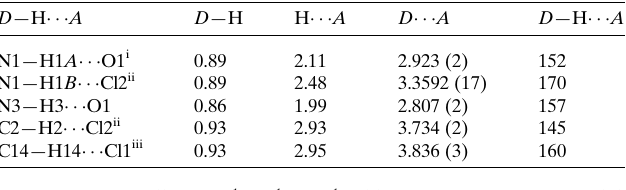
Table 1 Hydrogen-bond geometry (A˚ , (cid:3) ).